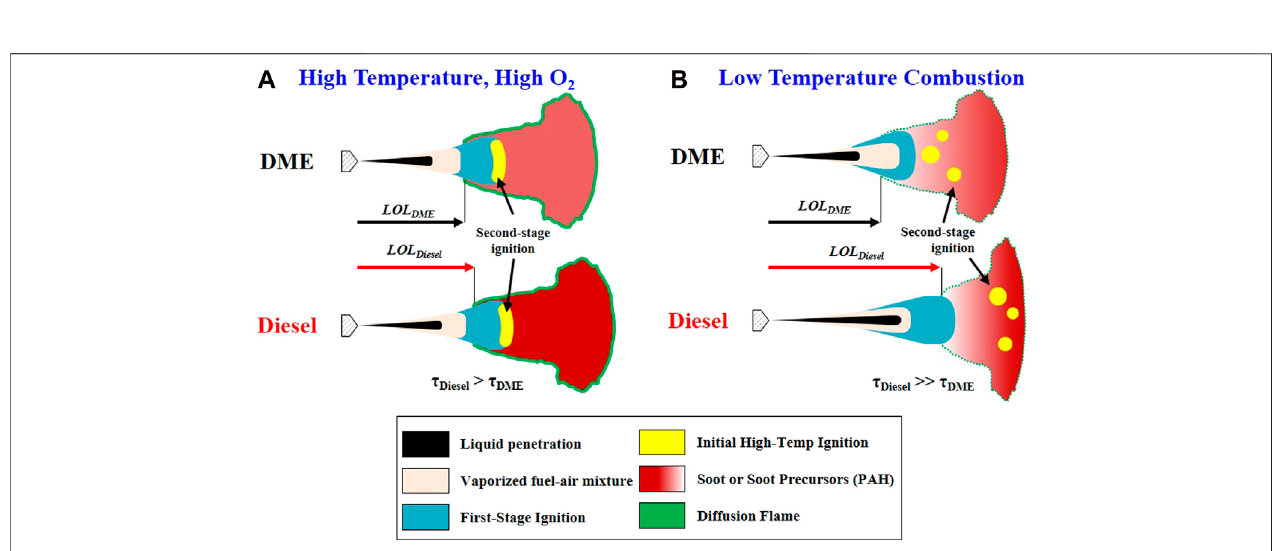
FIGURE 13 | Conceptual Mechanism of DME and Diesel reacting spray under (A) High temperature, high O 2 concentration, and (B) Low-temperature combustion.